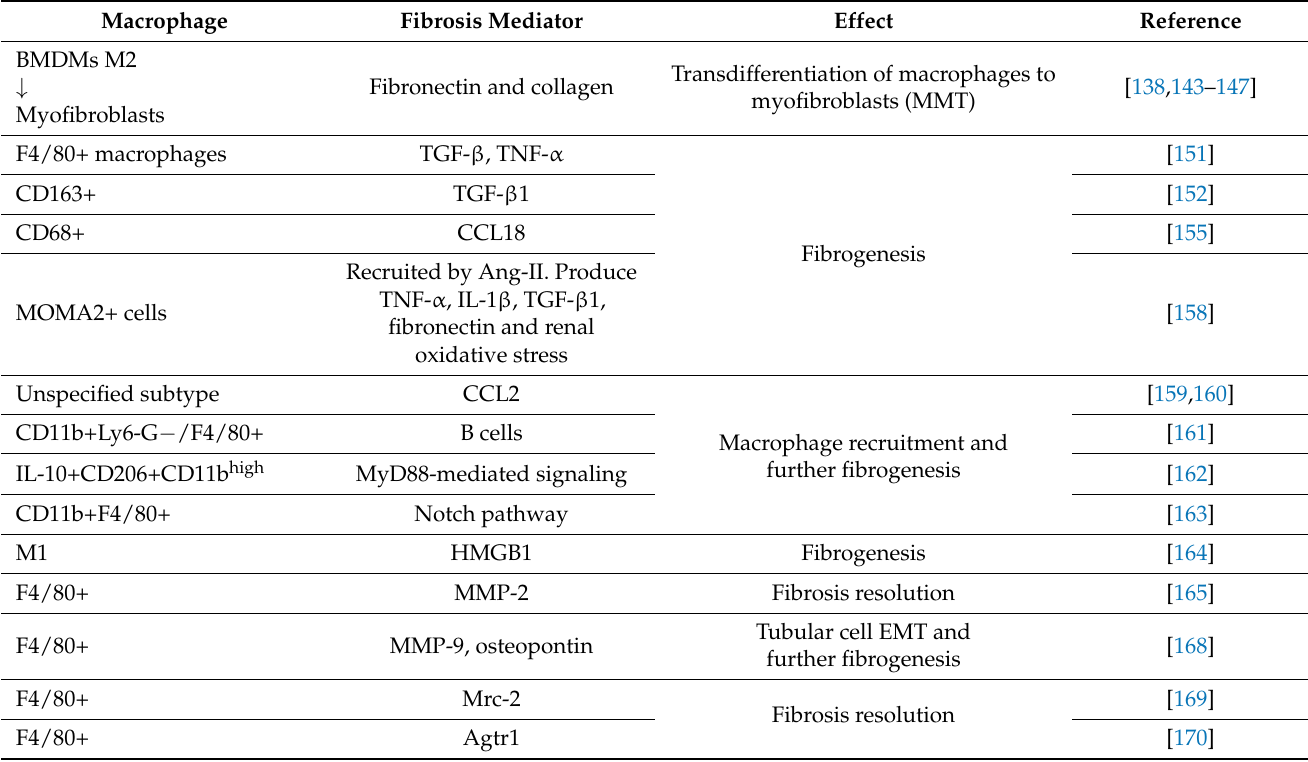
Table 4. Table summarizing how and which types of macrophages are involved in kidney fibrosis. Macrophage- myofibroblast transition (MMT), Transforming Growth Factor-beta (TGF- β ), Tumor necrosis factor-alpha (TNF- α ), In- terleukin (IL), High-mobility group box-1 (HMGB1), Chemokine C-C motif ligand (CCL), Angiotensin II (Ang-II), Matrix metalloproteinase (MMPs), Epithelial-to mesenchymal transition (EMT), Mannose receptor 2 (Mrc-2), and Ang-II type 1 receptor